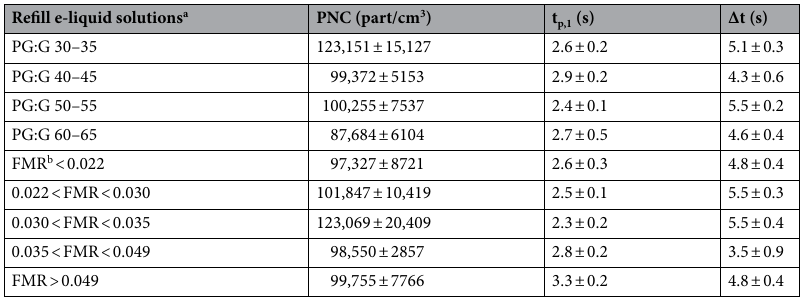
Table 2. Summary of PNC concentrations and events in e-vapors. ± standard error of the mean. Experiments were carried out using a 2 s puff and 15 s wait time at 100 W (n = 16). PNC particle number concentration, part/cm 3 particles per cubic centimeter, t p,1 time of the first peak PNC, s seconds, Δt time between two consecutive PNC, PG, propylene glycol, G glycerol, FMR flavorings molar ratio. a Refill e-liquid